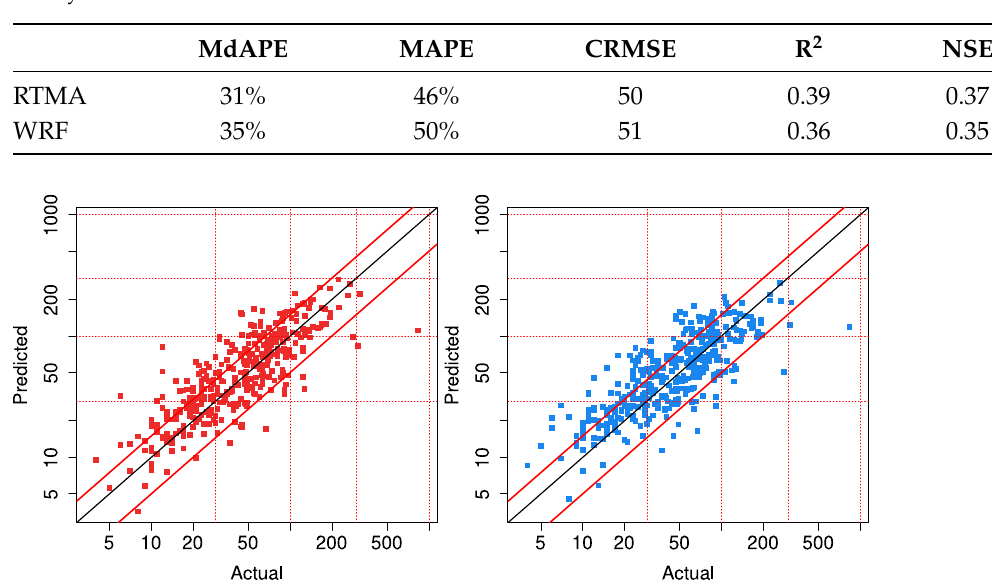
Table 3. Error metrics of the event-level performance of the cross-validation of the outage predic- tion systems.